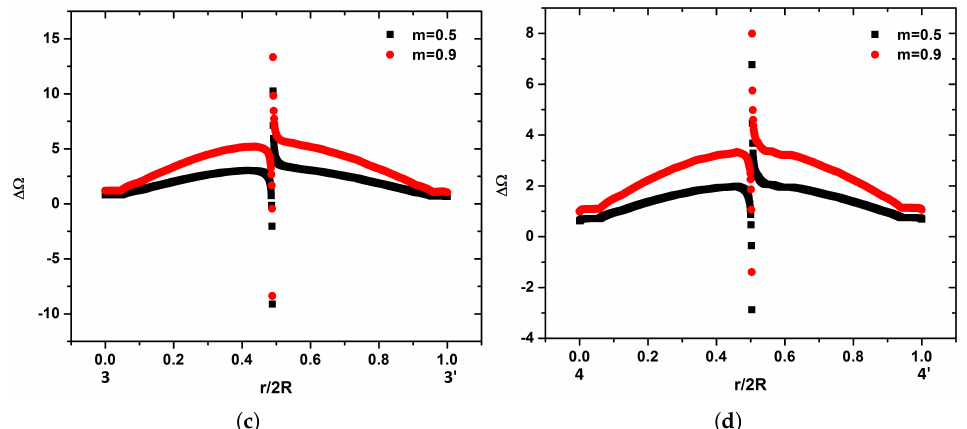
Figure 12. ∆Ω along the monitoring locations in the internal carotid artery : ( a ) 11 (cid:48) , ( b ) 22 (cid:48) , ( c ) 33, and ( d ) 44 (cid:48)